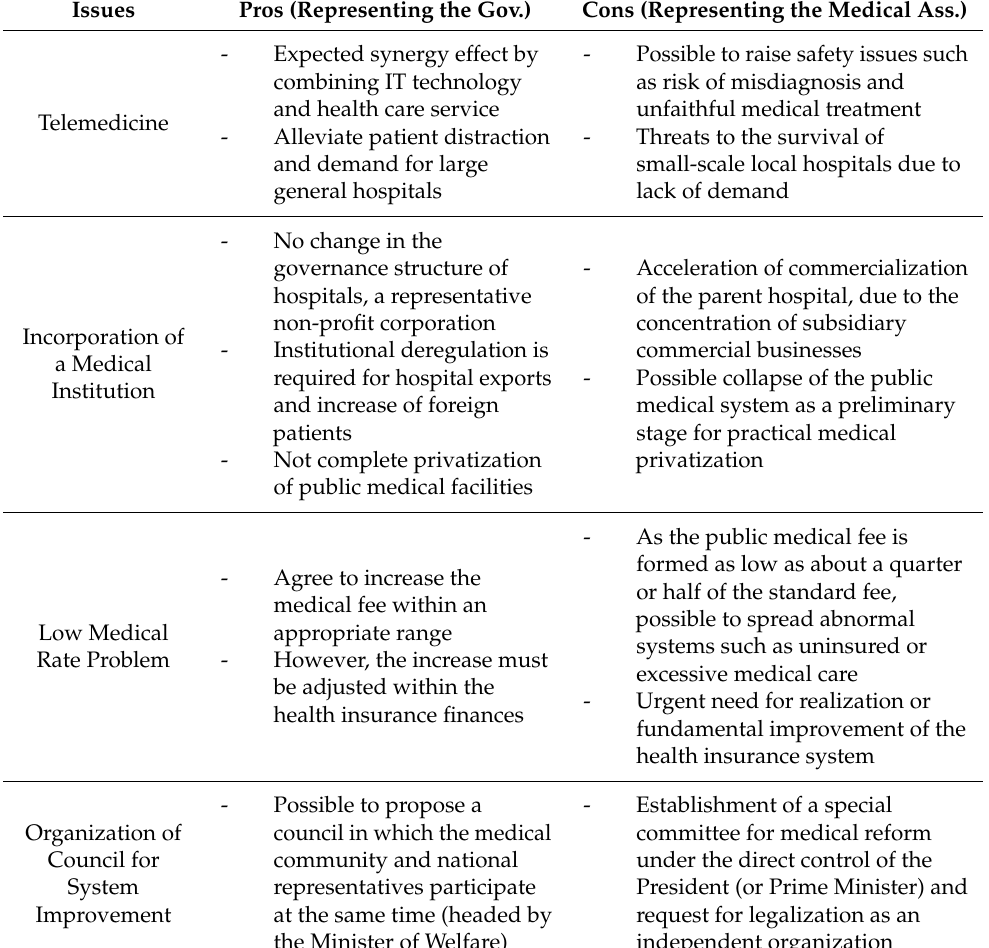
Table 3. Comparison of telemedicine between the government and medical associations.